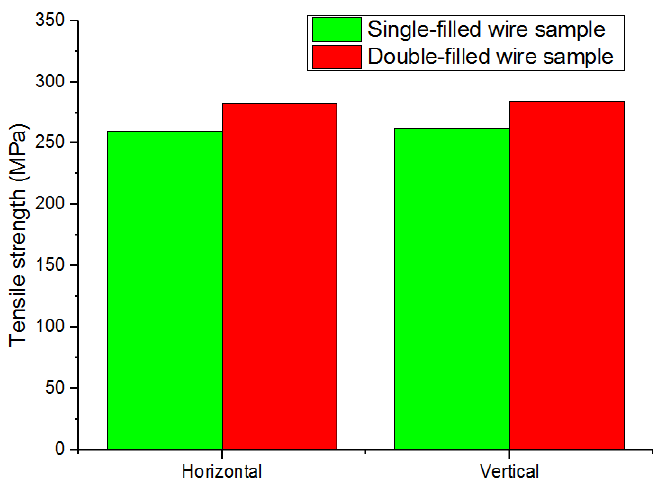
Figure 9. Tensile strength of single-filled and double-filled samples.